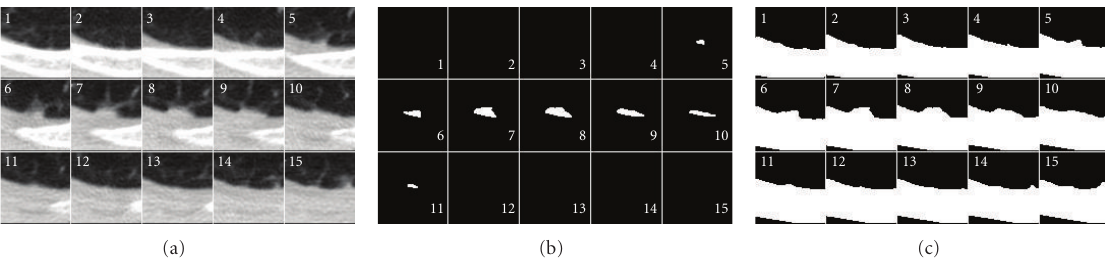
Figure 15: Example of a nodule where the segmentation performed by the surface-fitting algorithm is better than the segmentation performed by the plane-cutting method, with (a) the region of interest containing the nodule, (b) the nodule segmentation via the surface- fitting algorithm, and (c) the segmentation by the plane-cutting method. In (b) and (c), areas of white indicate